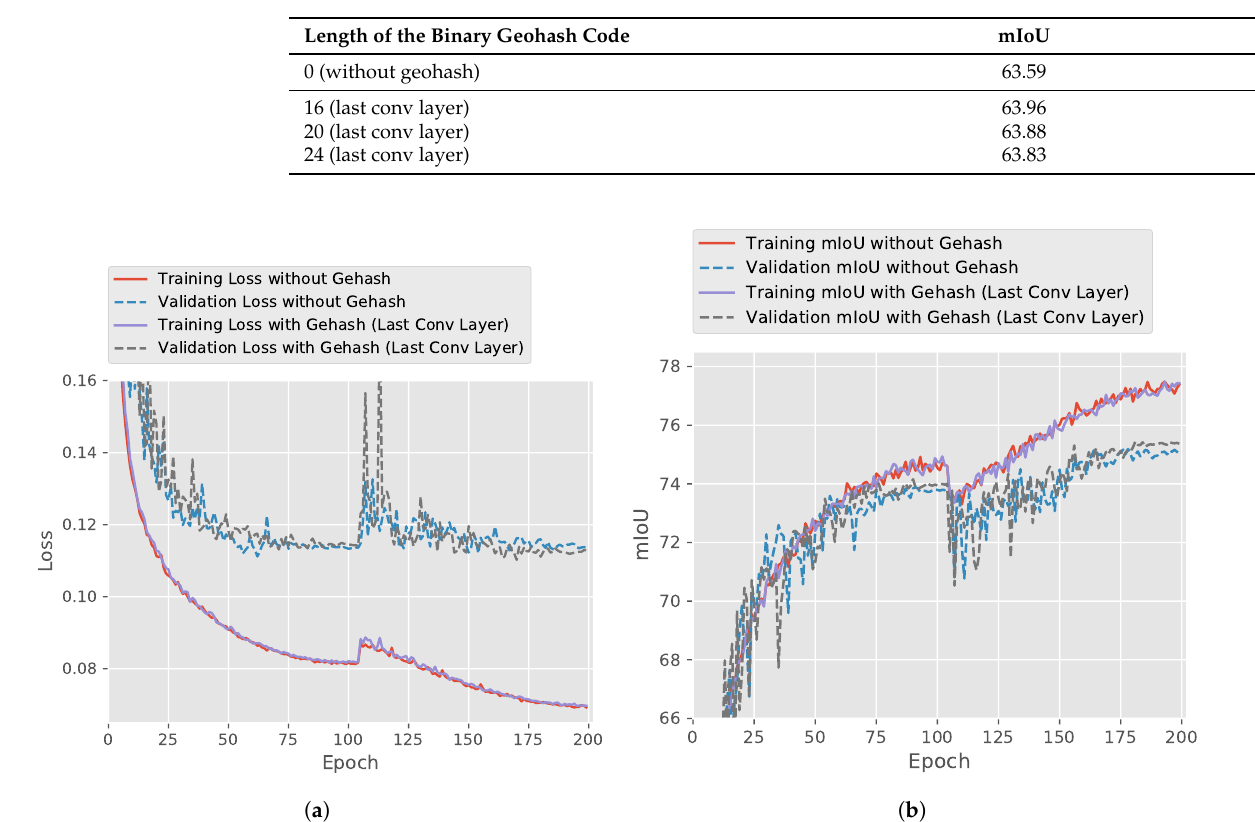
Table 7. Different lengths of the binary geohash on the DREAM-B dataset.